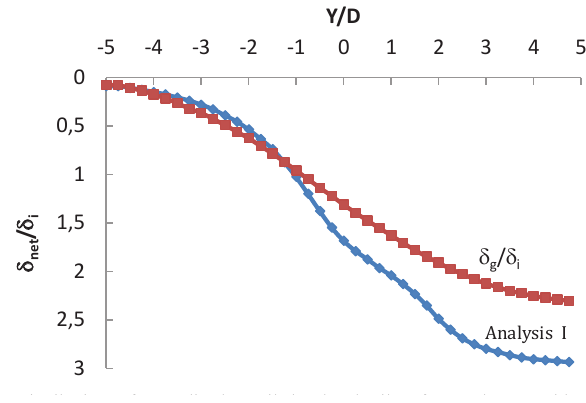
Fig. 6 Distributions of normalized net pile head and soil surface settlement with tunnel advancement for single pile